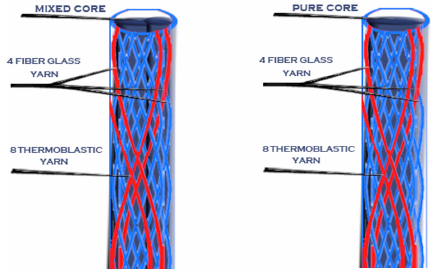
Figure 4. Sample 2 with different cores.